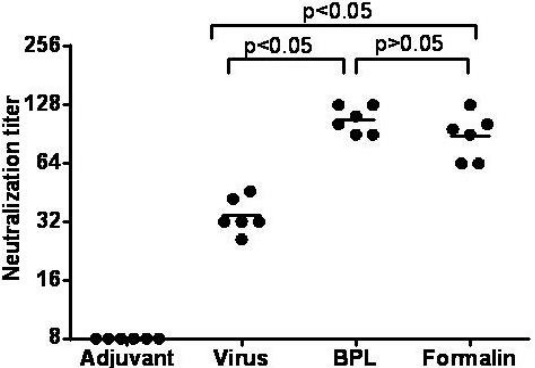
Figure 8. The serum neutralizing antibody responses to CA16 viruses prepared with different inactivation methods. Groups of ICR mice ( n = 6) were immunized with purified inactivated CA16 with or without adjuvant, or with adjuvant only as a control. Virus represents as inactivated by BPL and without adjuvant, BPL represents as inactivated by BPL and with adjuvant, Formalin represents as inactivated by formalin and with adjuvant Symbols represent reciprocal neutralizing antibody titers from groups of six animals. Neutralization titers (Y-axis) are plotted on a logarithmic scale.